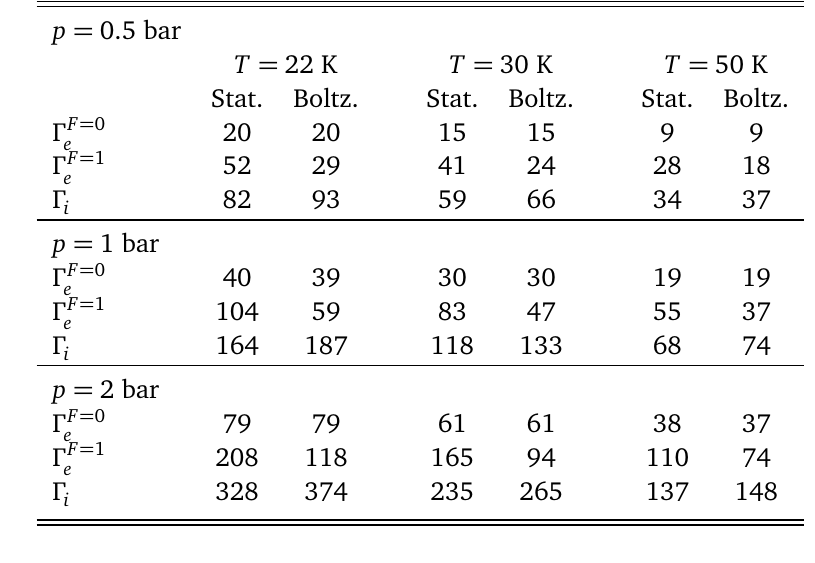
Table 1: µ p–H collision rates in MHz for various H 2 peratures ( T ). Two distributions of ortho- and para-H and